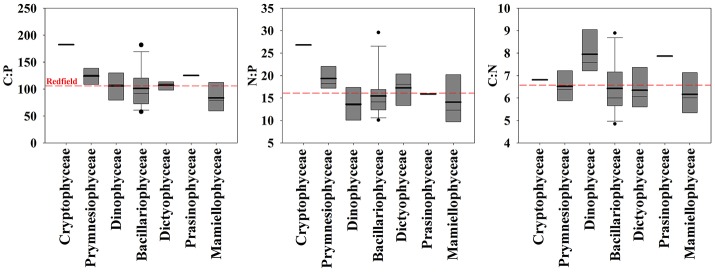
Comparison of cellular molar elemental ratios of carbon, nitrogen, and phosphorus among classes of 30 isolates of eukaryotic phytoplankton with box plots. The mean (bold line) and median (thin line) are plotted within the box which indicates quartiles. Whiskers indicate 10 and 90% quantiles and dots are outliers.